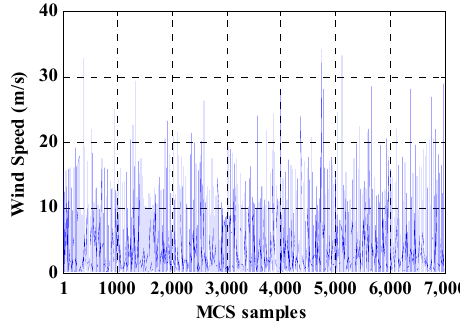
Figure 3. IEEE 33-bus radial distribution system.